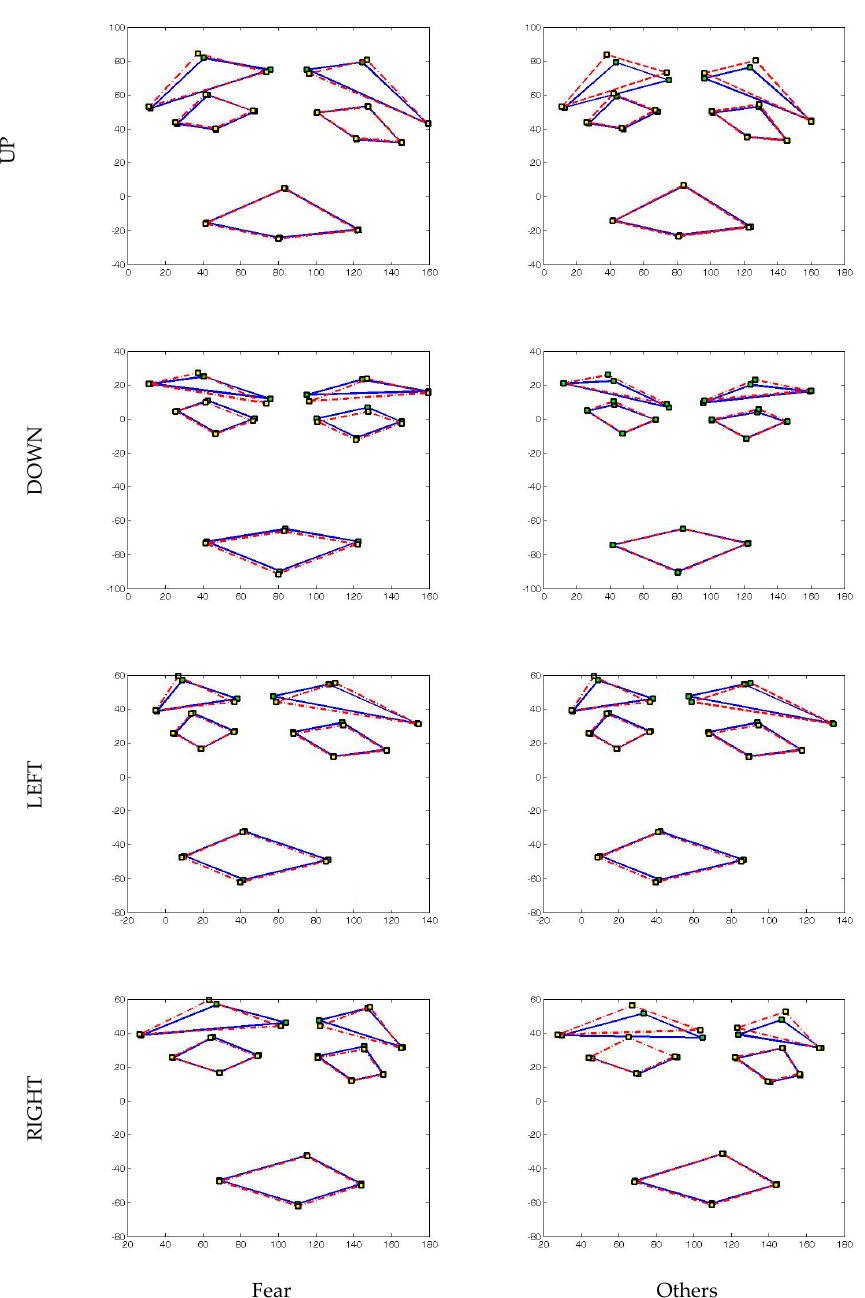
Figure 6. Example of obtained emotive images in 20° angular deviation and all orientations.